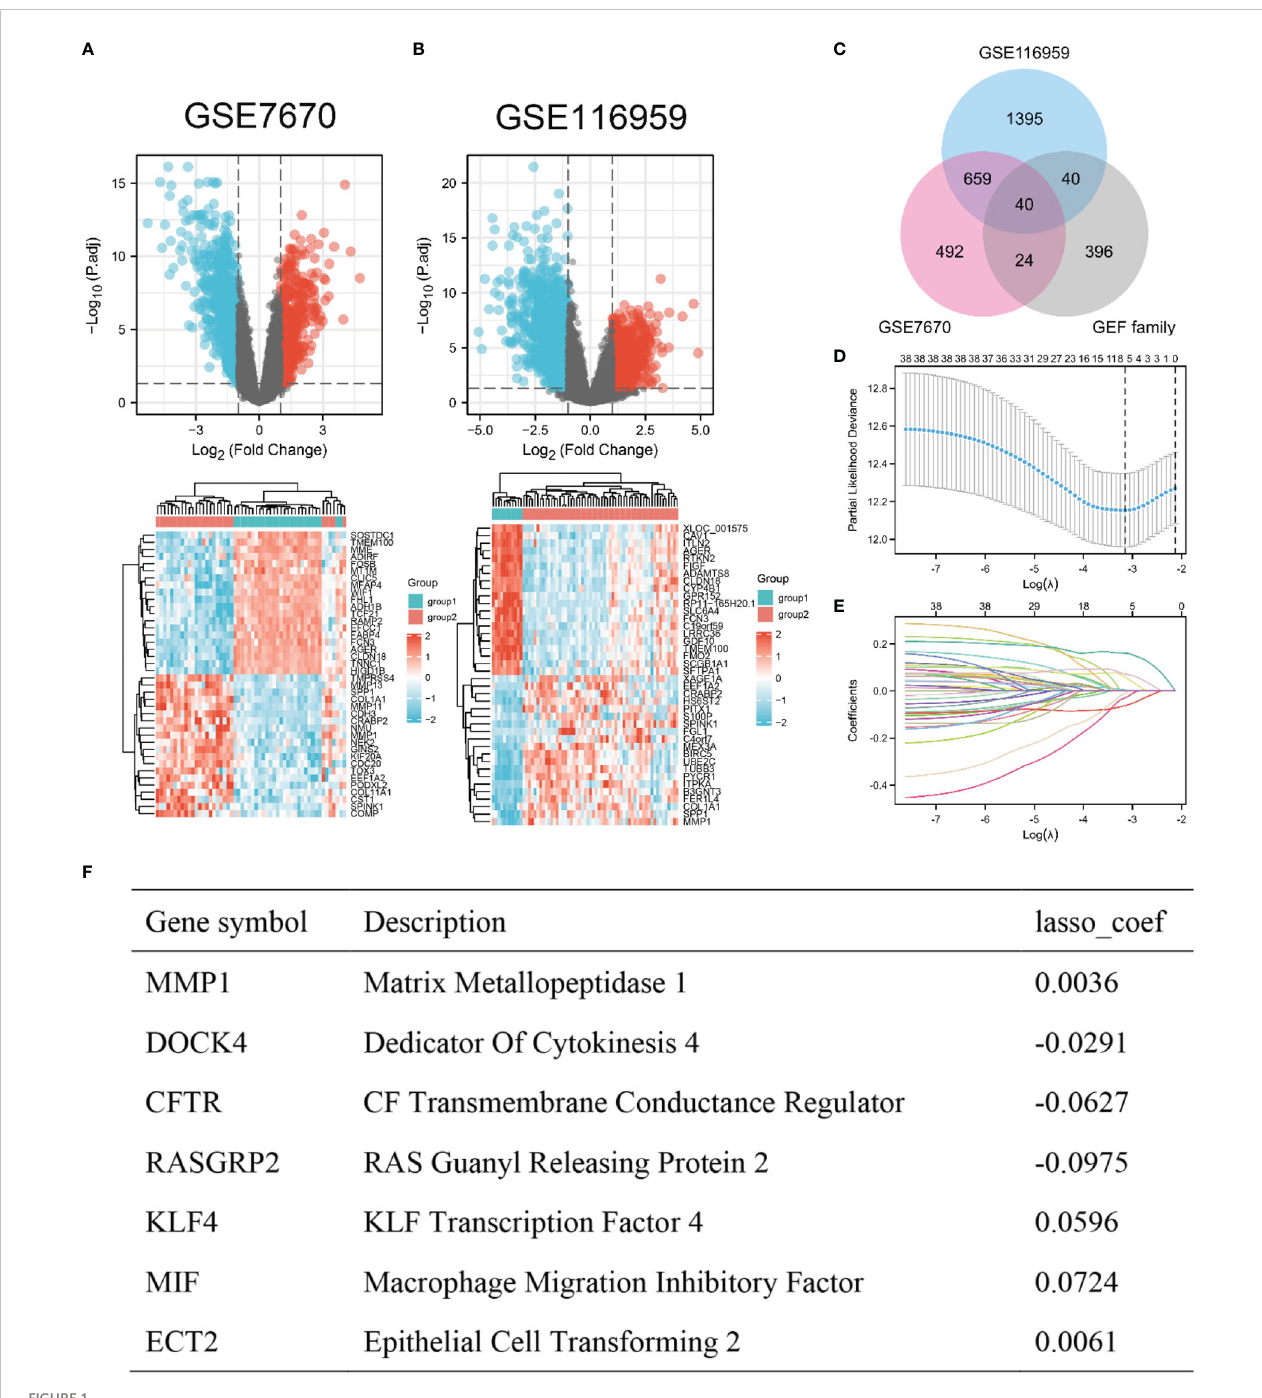
FIGURE 1 Screening of the overlap of DEGs and GEFs in LUAD. (A, B) Volcano plot (|log2(FC)| > 1, adj. P< 0.05) and heatmap plot (top 20) of DEGs in GSE7670 and GSE116959. (C) Overlap of DEGs and GEFs. (D) Cross-validation for tuning parameter screening in the LASSO regression model. (E) Coef fi cient pro fi les in the LASSO regression model. (F) Coef fi cients of 7 predictive genes in LASSO regression